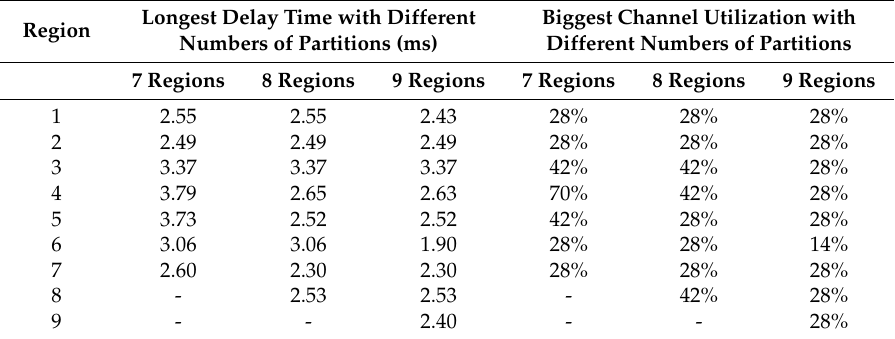
Table 6. Result contradistinction of communication indicators.